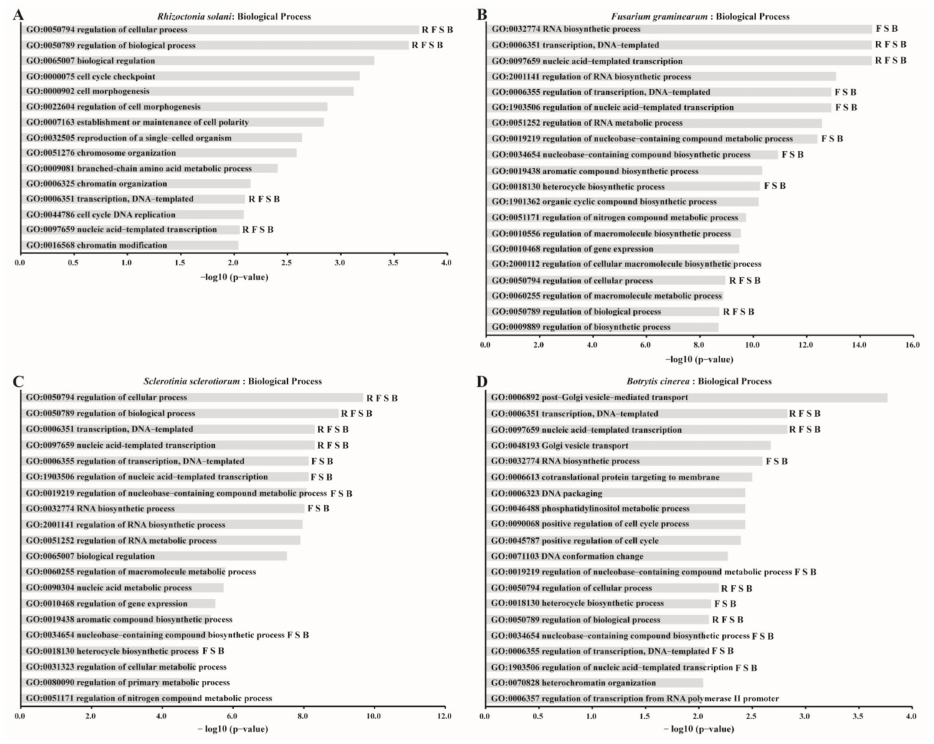
Figure 7. GO terms enrichment in the biological processes from fungal genes that have similar codon usage pattern to mycoviruses. The Y -axis shows the names of clusters of GO terms and the X -axis displays the − log10 ( p -value) of corresponding GO term. GO terms with p < 0.01 were taken as a significant enrichment. ( A – D ) showed the top 20 of significant enriched GO terms from R. solani genes ( A ), F. graminearum genes ( B ), S. sclerotiorum genes ( C ), and B. cinerea genes ( D ), respectively. The alphabets indicate GO terms that which were co-enriched in different fungi; R ( R. solani ), F ( F. graminearum ), S ( S. sclerotiorum ), and B ( B. cinerea